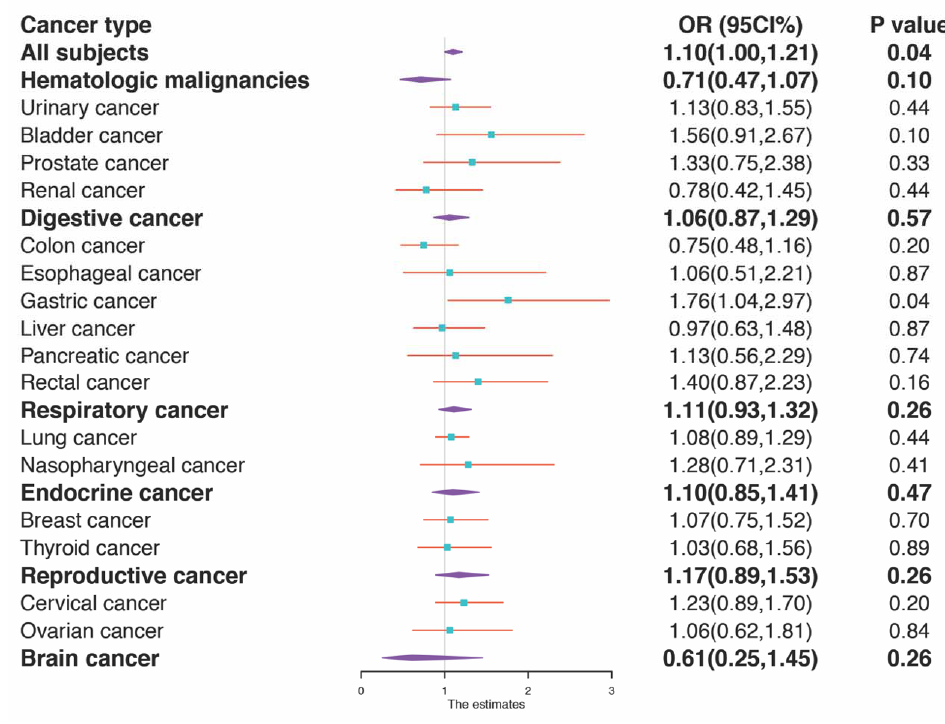
Figure 3. A forest plot of the association between HEV anti-seropositivity and the risk of cancer. A forest plot for HEV seropositivity and the risk of cancer is presented by cancer subtypes. Subtype- specific odds ratios (OR) adjusted by all studied risk factors and 95% confidence interval (95% CI) are denoted by cyan boxes. The p value for OR by subtype is shown as well.